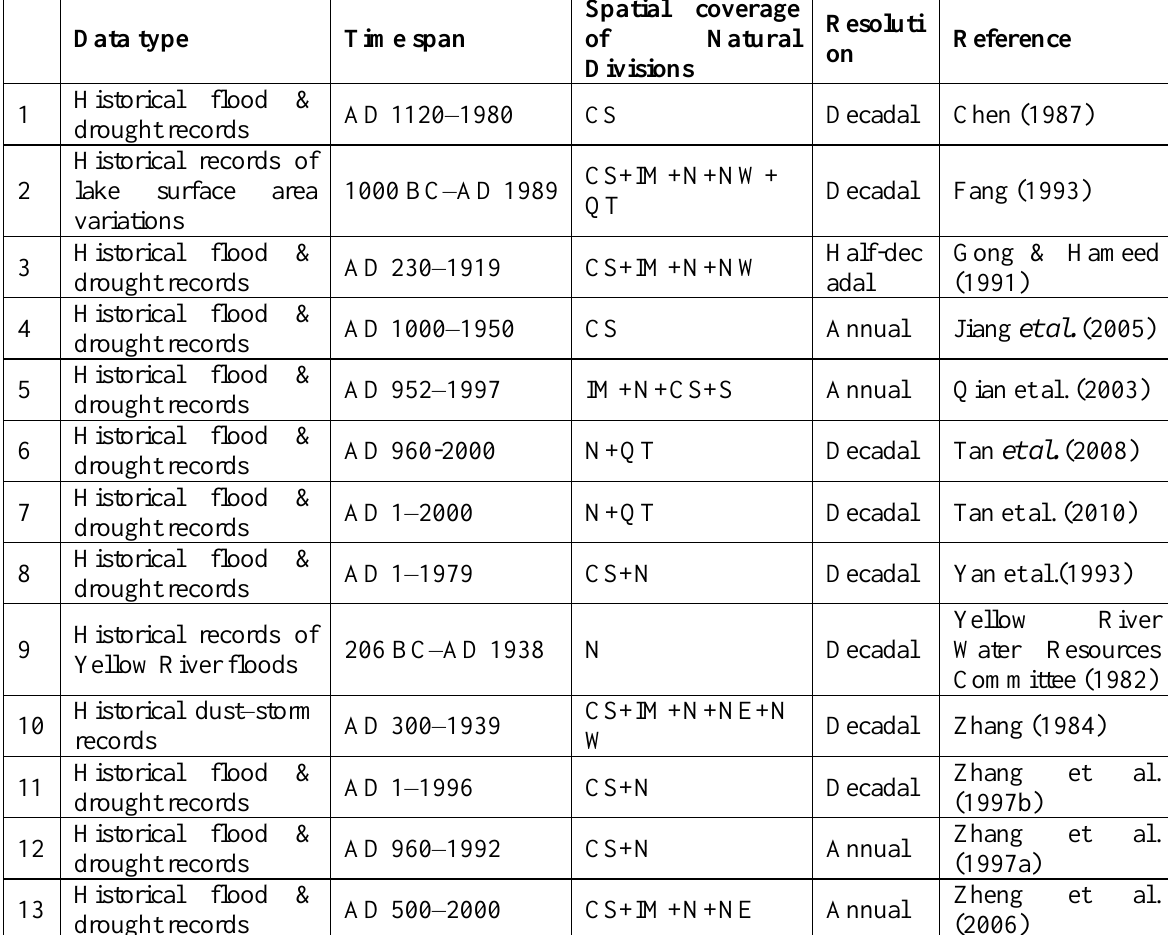
Table A1 Data source for precipitation anomaly